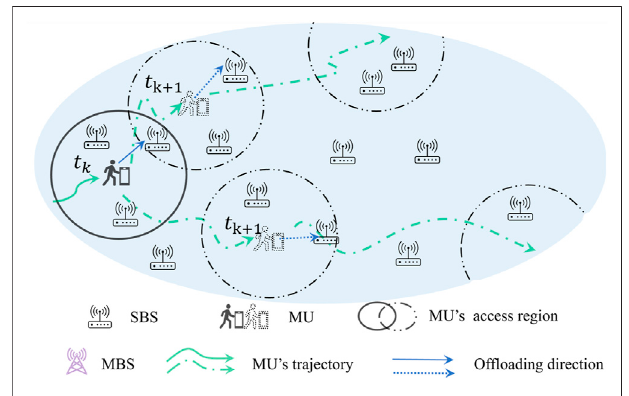
FIGURE 2 | Illustration of user-centric task of fl oading for MEC in UDN. The two dotted lines represent the uncertain future tracks of the